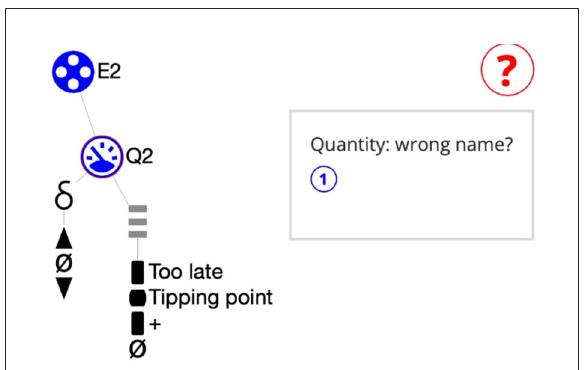
FIGURE3 Cueing and Advice (Spitz et al., 2021a). While creating the details a quantity is wrongly named. Cueing highlights the erroneous ingredient (here: Q2). Advice suggests an error. Here: Quantity: wrong name.